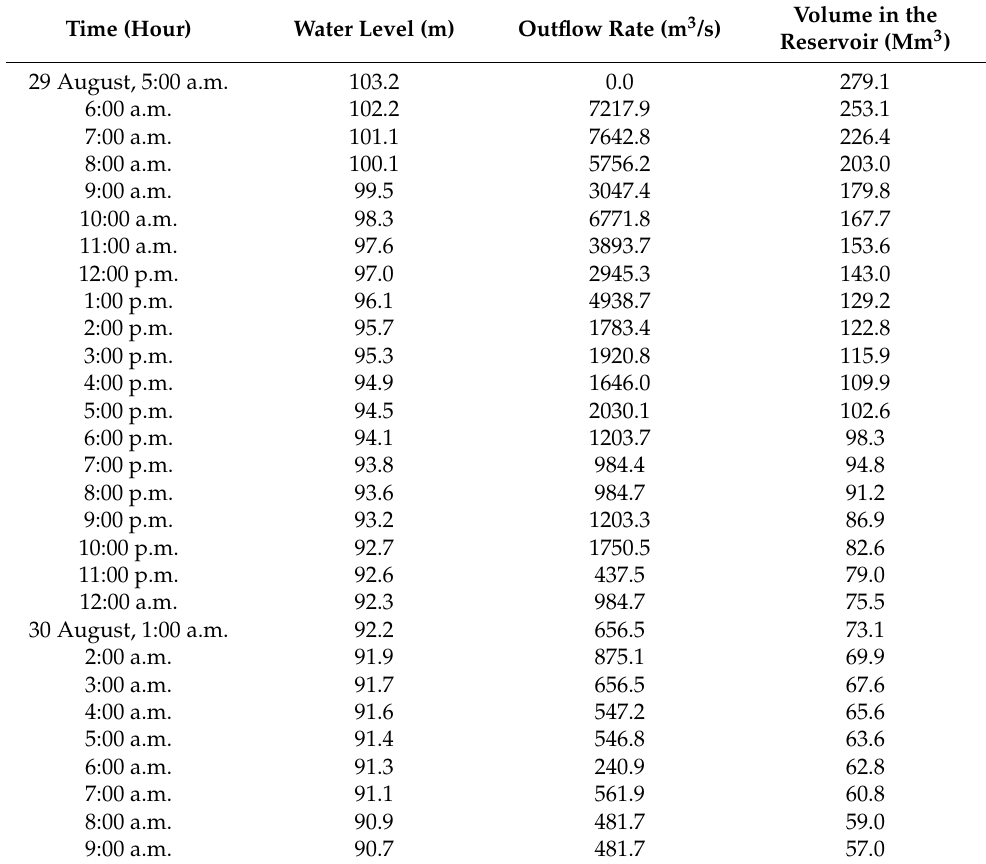
Table A3. Hourly water level, equivalent reservoir water volume and calculated breach outflow during the Swa Dam breach event.